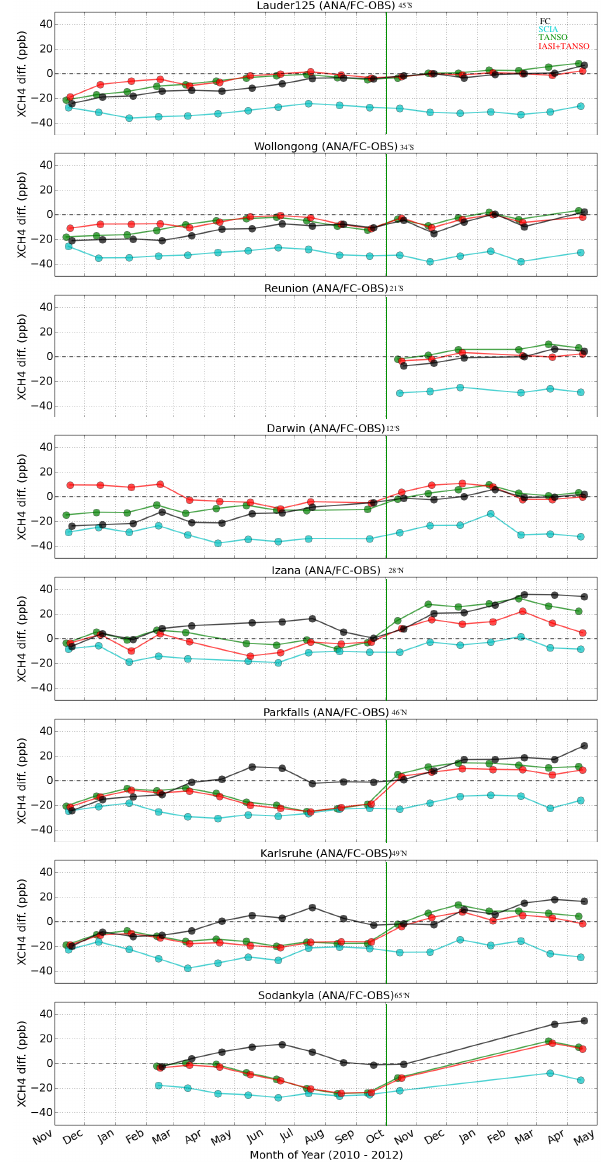
Figure 10. Time series of the monthly differences (in ppb) between xCH 4 measurements from the TCCON network and xCH 4 from the Fig. 10. Time series of the monthly differences (in ppb) between x CH free experiment (black) and from the analyses (cyan: SCIA, green: experiment (black) and from the analyses (cyan: SCIA, green: TANSO, red: IASI + TANSO). The stations are ordered from top to bottom TANSO, red: TANSO+IASI). The stations are ordered from the top to the bottom panel by their latitude, from south to north: Lauder, panel by their latitude, from south to north: Lauder, Wollongong, Reunion, Darwin, Park Falls, Garmich, Karlsruhe, Sodankyla. Wollongong, Reunion, Darwin, Park Falls, Garmisch, Karlsruhe,